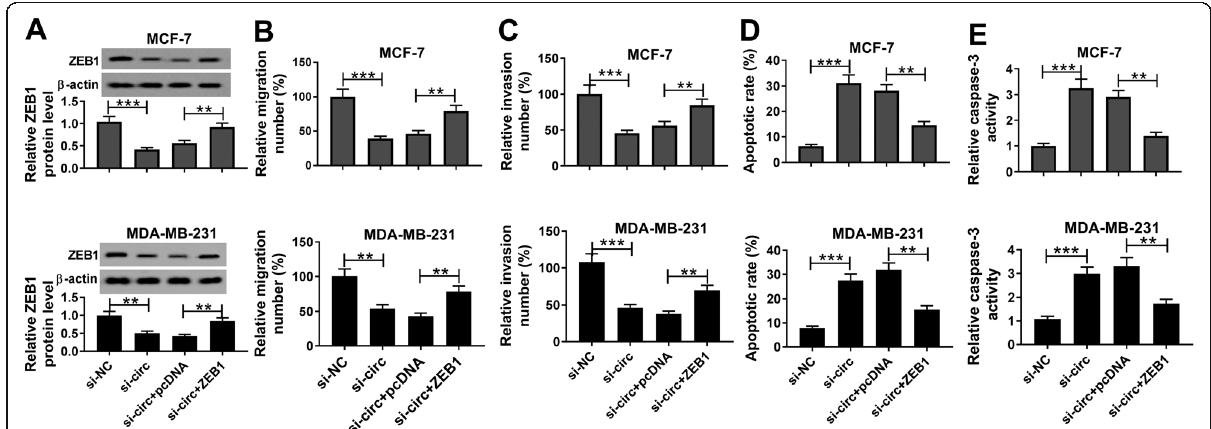
Fig. 6 ZEB1 overexpression rescued the impacts of circKIF4A silencing on cell migration, invasion and apoptosis in BC cells. MCF-7 and MDA-MB- 231 cells were treated with si-circKIF4A, si-NC, si-circKIF4A + ZEB1 or si-circKIF4A + pcDNA. ( a ) The expression of ZEB1 was measured through western blot assay. ( b and c ) Cell migration and invasion were assessed by transwell assay. ( d ) Cell apoptosis ability was detected by flow cytometry. ( e ) The level of caspase-3 was evaluated by qRT-PCR. **P < 0.01, ***P < 0.001